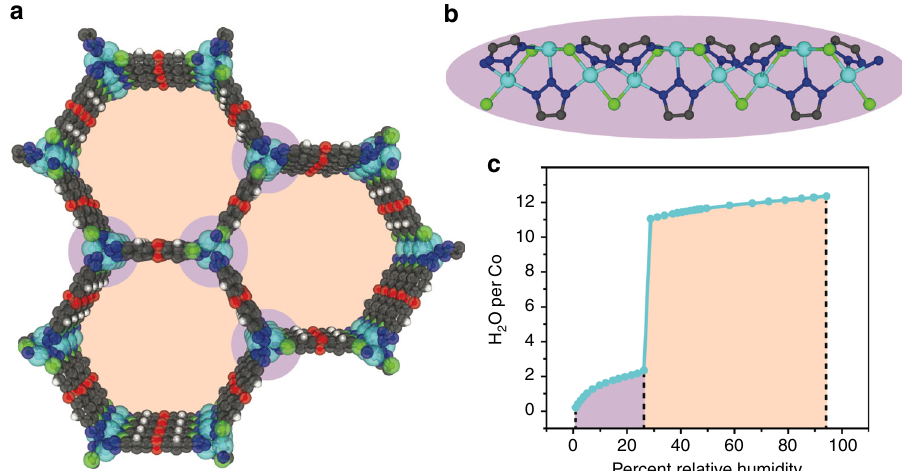
Fig. 1 Structure and Water Adsorption of Co 2 Cl 2 BTDD. a Structure of Co 2 Cl 2 BTDD viewed down the z -axis. C – gray, H – white, O – red, N – dark blue, Cl – green, Co – light blue. Hydrophilic regions are indicated in purple and hydrophobic regions in orange. b Structure of the secondary building unit along the z -axis. c Water adsorption isotherm at 20 °C for Co 2 Cl 2 BTDD exhibiting complete pore hydration at 28% RH, data adapted from ref.